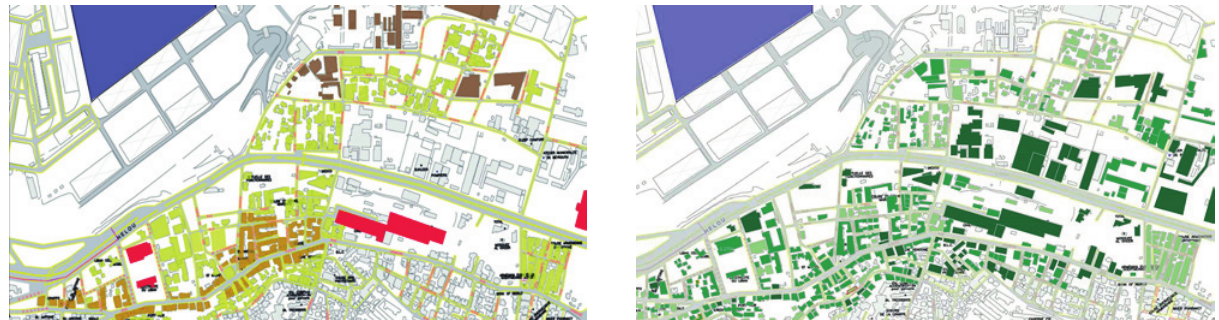
Figure 6. (Left Image) Land use map, (Right Image) Building age